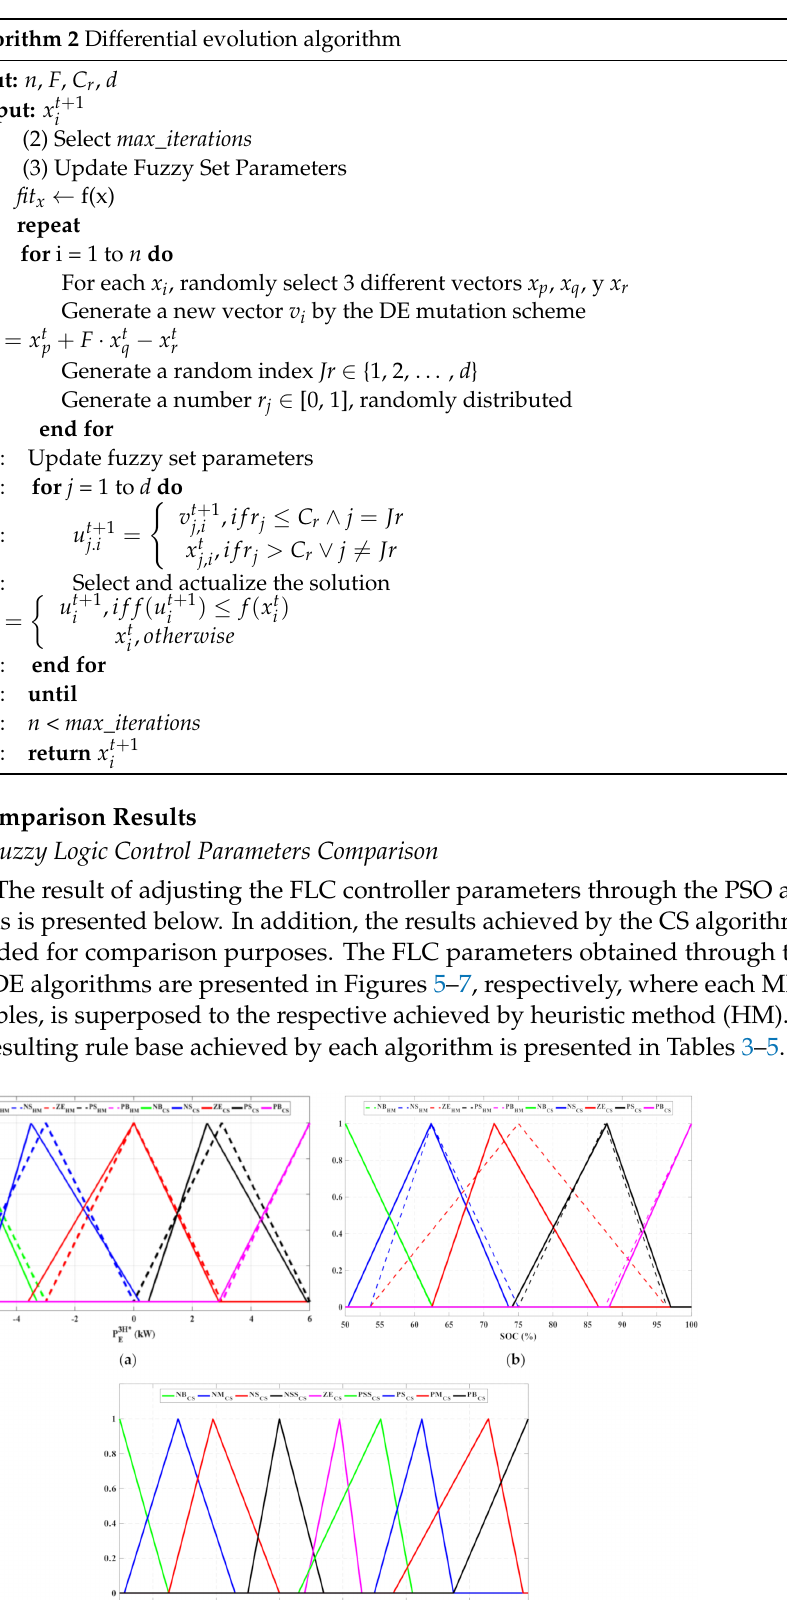
, ( b ) input SOC , and E